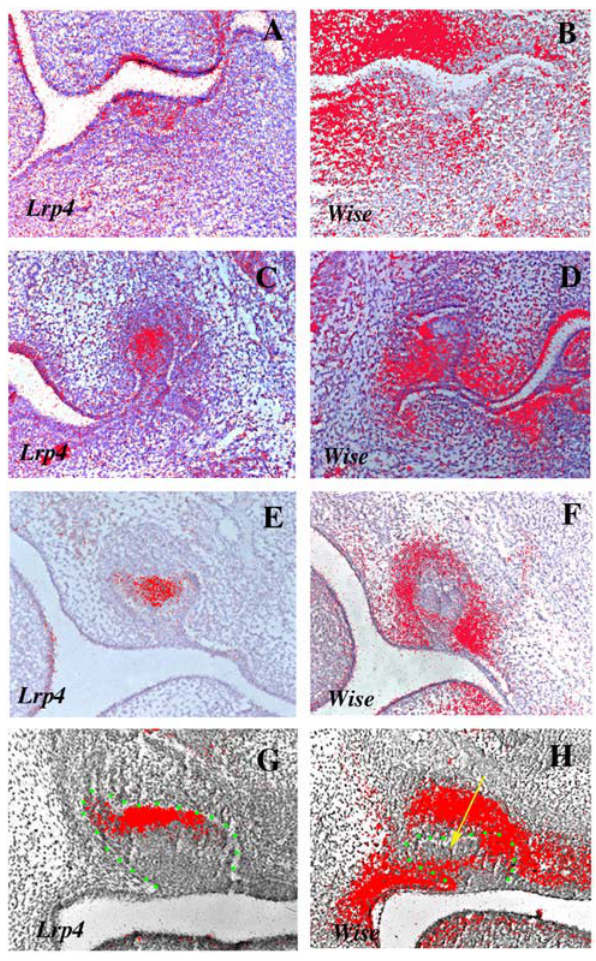
Figure 2. The expression patterns of Lrp4 and Wise during early molar and incisor tooth development. (A, B) Lrp4 was expressed in tooth epithelium whereas Wise expression was observed in tooth mesenchyme. (C, E) The expression of Lrp4 was restricted to the primary enamel knots. (D, F) Wise expression was found in both epithelium and mesenchyme but was absent from primary enamel knots. (G, H) Sections showing complementary expression of Lrp4 (G) and Wise (H) in incisor regions. Yellow arrow representing the region of Lrp4 expression (H). Tooth epithelium outlined in green (G, H). Radioactive in situ hybridisation on frontal sections showing Lrp4 expression (A, C, E, G) and Wise expression (B, D, F, H) in embryo heads at E12.5 (A B), E13.5 (C, D) and E14.5